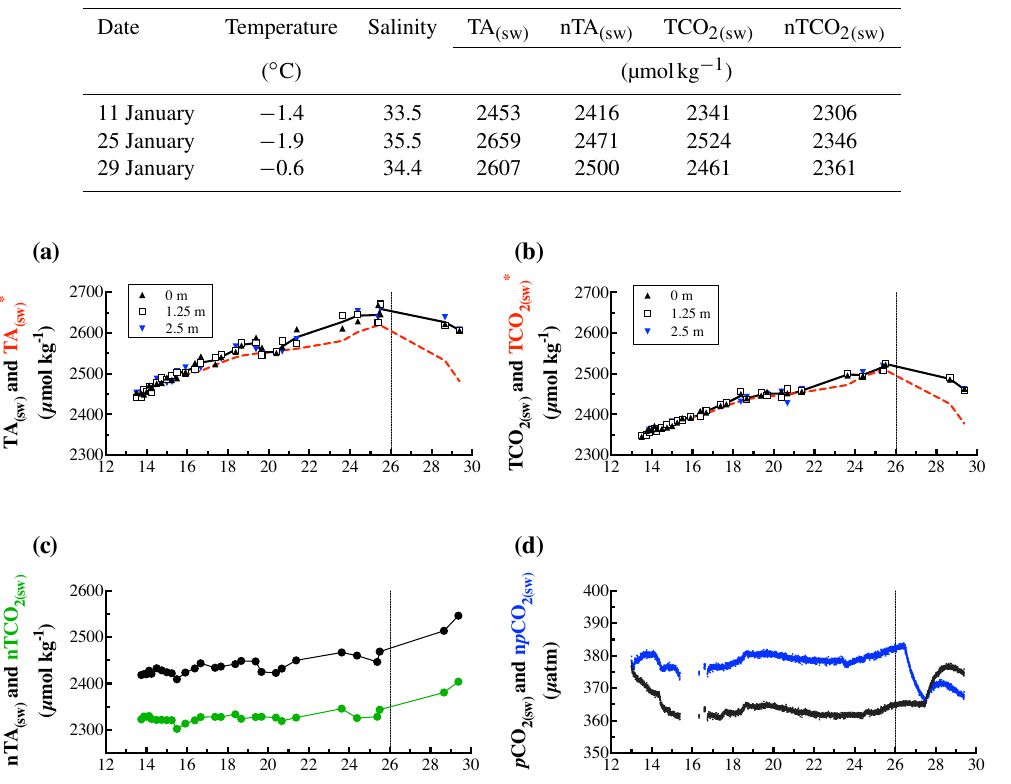
Table 1. Seawater conditions on 11 January, before any sea ice formation ( t = 0), on 25 January, just before the heat was turned back on and on 29 January, at the end of the experiment. Note that seawater salinity and TA (sw) do not reach the initial seawater values as sea ice was still present at the end of the experiment.